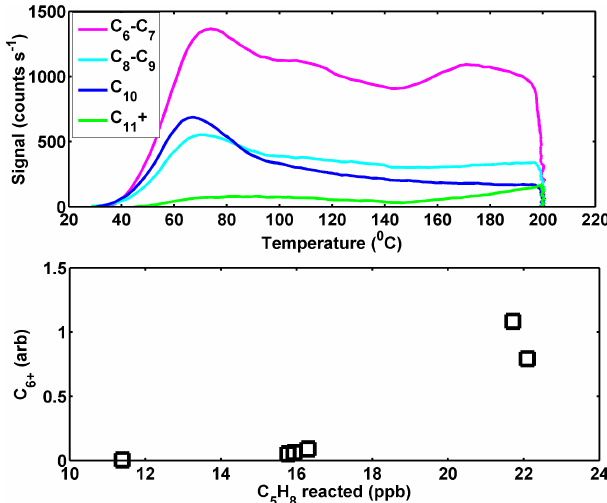
Figure 6. Top: sum of the thermogram signal for compounds with the formula C x H y O z I − , where x is varied across each thermogram and represents compounds with six or more carbons. Bottom: the sum off the mass concentration of all compounds with six or more carbons relative to the mass concentration of organic aerosol as a function of reacted